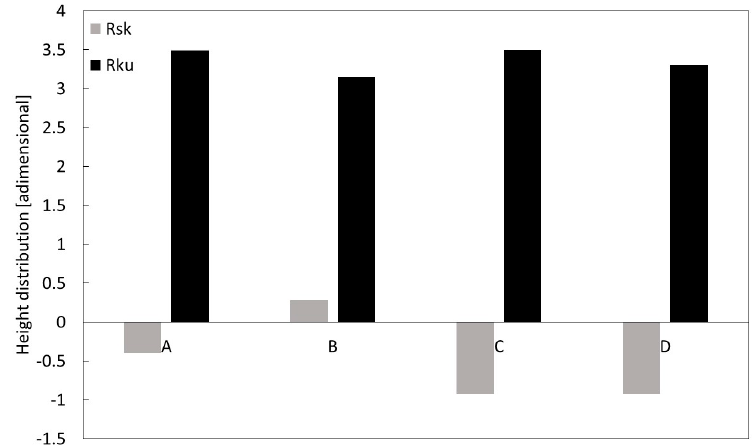
Figure 6. Height distribution of the dental implants’ roughness profiles estimated through the dimensional parameters R sk and R ku , taken with Leica Map.